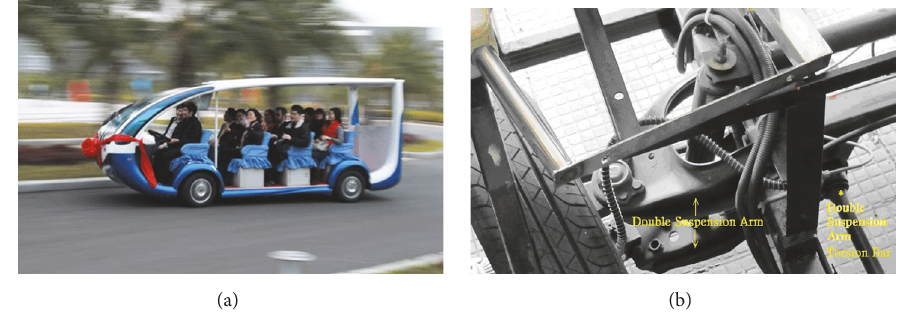
Figure 1: (a) The electric sight-seeing car; (b) the double suspension arm torsion bar of